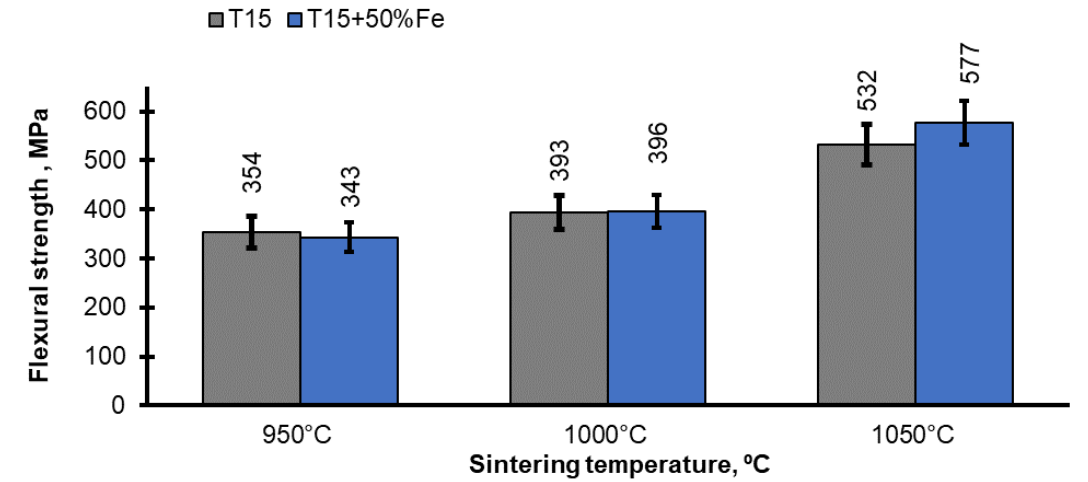
Figure 5. Flexural strength of as-sintered T15 and T15+50%Fe materials.